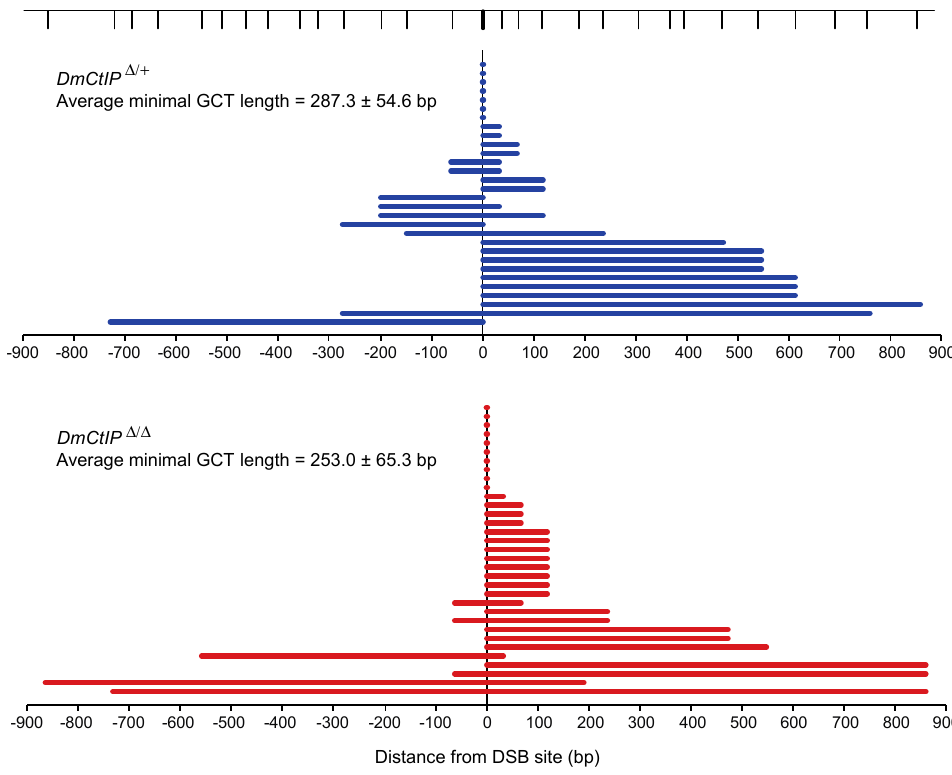
Figure 4. DmCtIP does not impact gene conversion tract (GCT) lengths. HR repair events result in GCTs in both DmCtIP ∆ / ∆ mutants (red, n = 33) and DmCtIP ∆ /+ heterozygous controls (blue, n = 30). SNPs along the length of the donor sequence are indicated at top (vertical lines). The zero mark represents the DSB site. The last converted SNP is shown and plotted as minimal gene conversion tracts lengths. Average minimal GCT lengths ± S.E.M. are provided for each genotype ( p = 0.69, Student’s t -test).